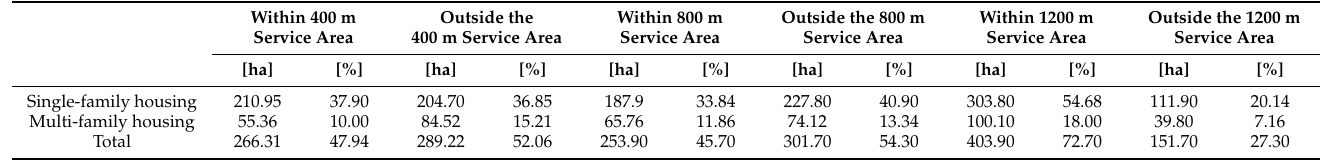
Figure 12. Distribution of PGS in the study area: ( a ) current state; ( b ) land use plans. Implementation of the land use plans aims to improve the accessibility of the PGS at each of the ranges adopted in the standards, yet there will be part of the residential sites outside of the PGS service areas. There will be 47.94% (266.31 ha) of residential sites within the walking distance of 400 m to PGS I, II, and III, and 52.06% (289.22 ha) outside of it. Within the 800 m walking distance to PGS II and III there will be 253.86 ha or 45.7% of residential sites and 301.67 ha or 54.3% outside of it. A total of 403.86 ha (72.7%) of residential land will be located within the 1200 m range and 151.67 ha (27.3%) outside of it. The results of the analysis of PGS accessibility within each range are summarised in Table 5, and shown on the Figures 13 and 14. Table 5. Residential sites located within the service areas of PGS and outside, according to land use